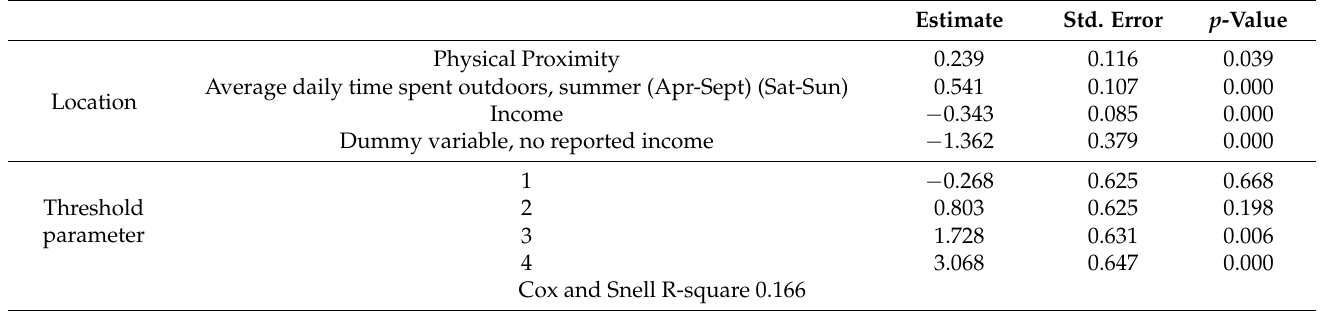
Table 6. Results of the ordered logit model in which the dependent variable is public life use in the form of stationary